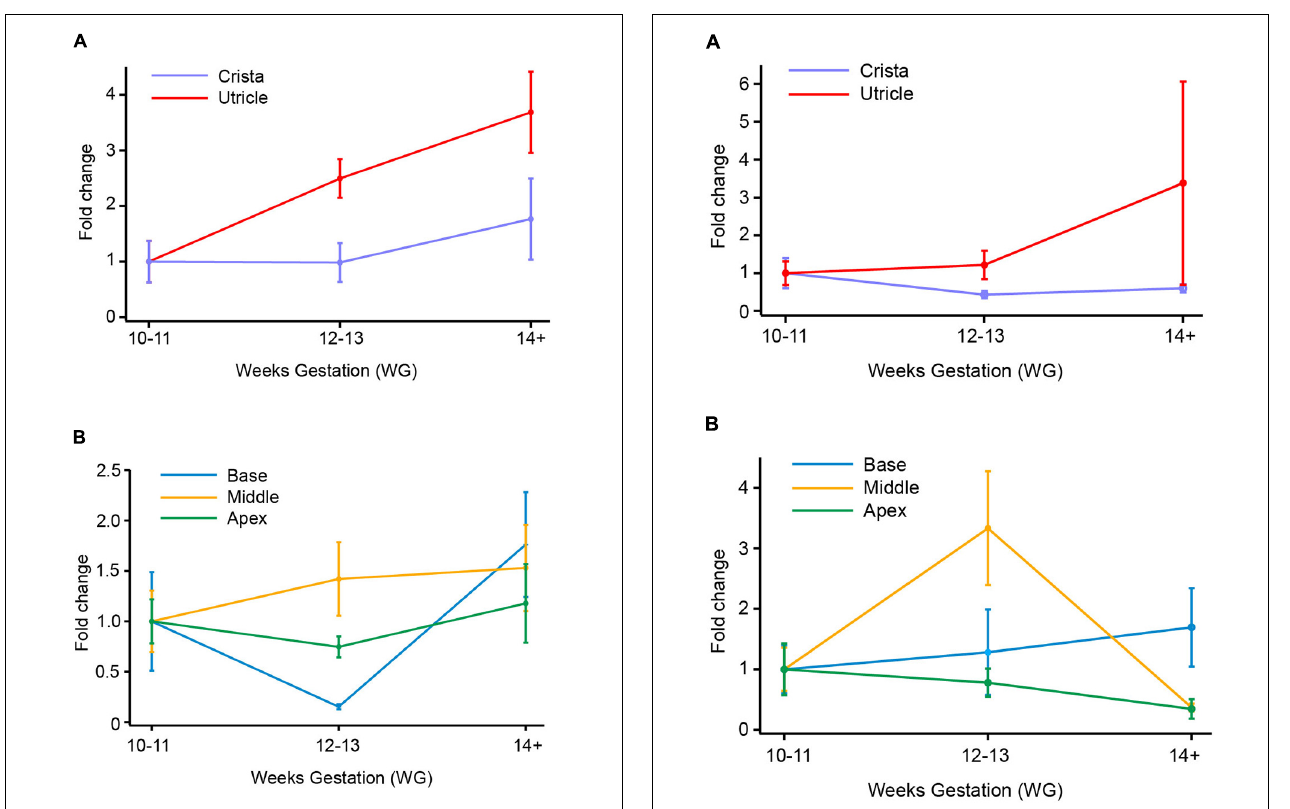
FIGURE 3 | SCN9A (Nav1.7) mRNA in vestibular organs and cochlea. (A) There was a slight decrease in SCN9A expression with age in the crista, with the lowest expression level at 12–13 WG (0.4-fold change). In utricle, there was a slight increase in SCN9A expression at 12–13 WG, to peak at 14+ WG with a 3.4-fold change in SCN9A expression relative to the 10–11 WG age group. (B) SCN9A expression in the base of the cochlea increased with age to peak at 14+ WG with a 1.7-fold increase compared to 10–11 WG. There was a 3.3-fold increase in SCN9A expression in the middle region of the cochlea at 12–13 WG, which then dramatically decreased at 14+ WG resulting in a 0.4-fold decrease compared to 10–11 WG. There was a decrease in SCN9A expression with age in the apex of the cochlea with lowest expression at 14+ WG (0.006-fold compared to 10–11